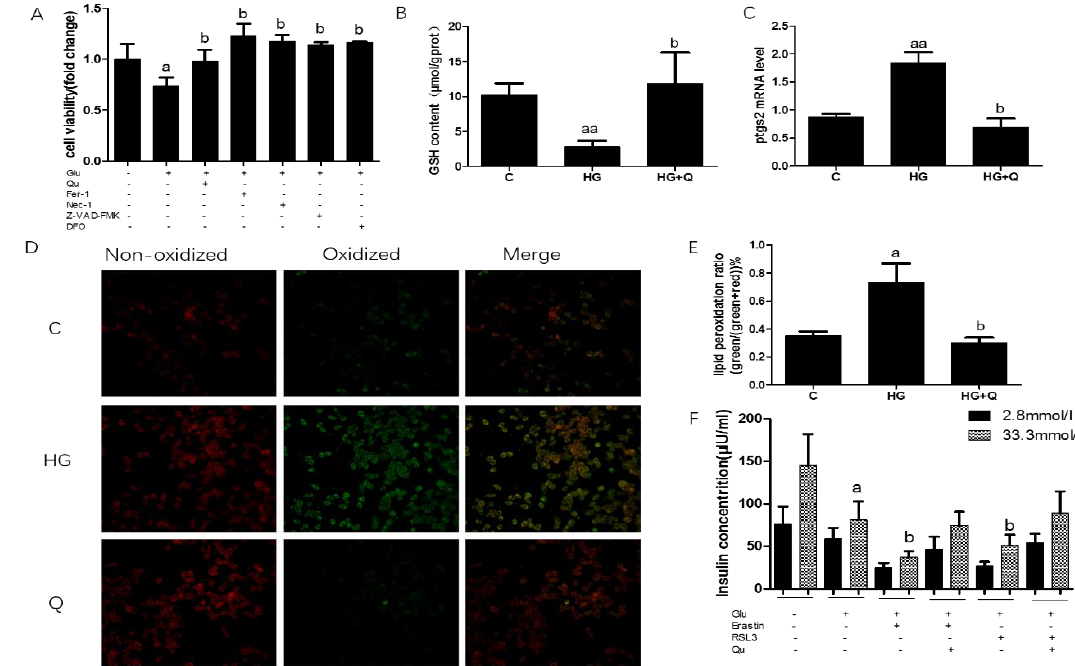
Figure 6. Quercetin alleviates ferroptosis-related phenotype in INS-1 cells induced by high glucose. ( A ). Cell viability was measured in INS-1 cells treated for 48 h with high glucose (33.3 mmol / L), quercetin (50 µ M), Fer-1 (2 µ M), Z-VAD-FMK (10 µ M), Nec-1 (10 µ M), deferoxamine (DFO) (25 µ M); ( B ). GSH level was determined in INS-1 cells treated for 48 h with high glucose (33.3 mmol / L), quercetin (50 µ M). ( C ). Ptgs2 mRNA level was determined in INS-1 cells treated for 48 h with high glucose (33.3 mmol / L), quercetin (50 µ M), and normalized to β -actin mRNA; ( D ). Fluorescence micrographs of INS-1 labeled for 30 min with 1 µ M C11-BODIPY 581 / 591 ( n = 3); ( E ). Quantification of fluorescence intensity calculated by dividing the green image by the sum of the green and red images ( n = 3); ( F ). Glucose stimulated insulin secretion when treated for 48 h with erastin (1 µ M) and RSL-3(1 µ M). Data were expressed as mean ± SEM (a: p < 0.05 vs. C; aa: p < 0.01 vs. C; b: p < 0.05 vs. high glucose (HG)).